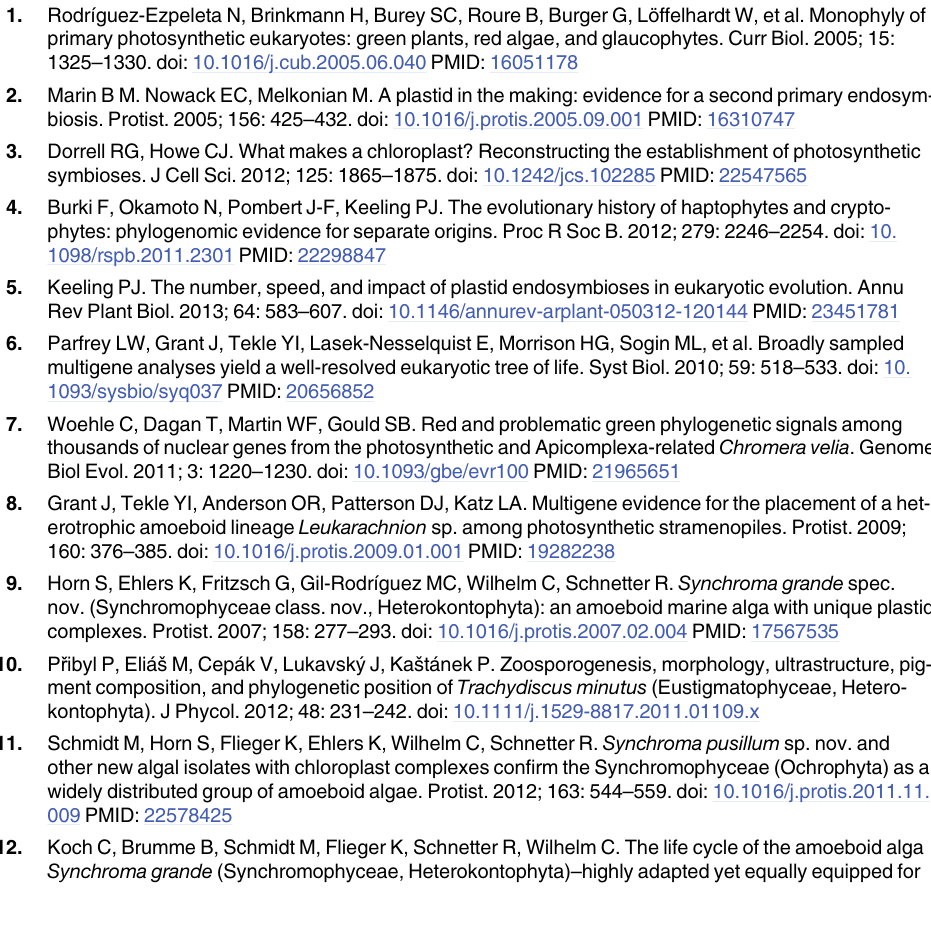
S3 Table. Comparison of support values for the S . grande , S . pusillum and Synchroma clade in phylogenetic analyses under different